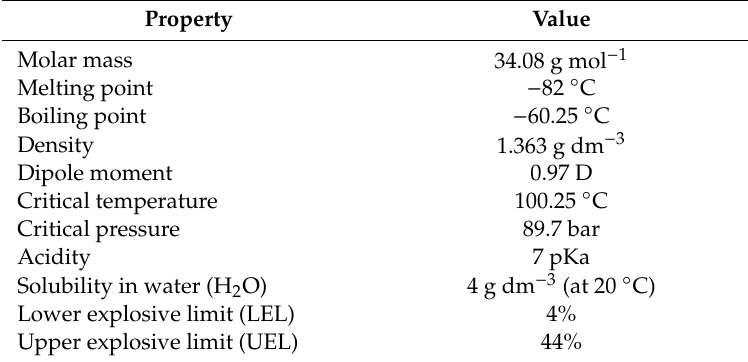
Table 1. Physicochemical properties of H 2 S